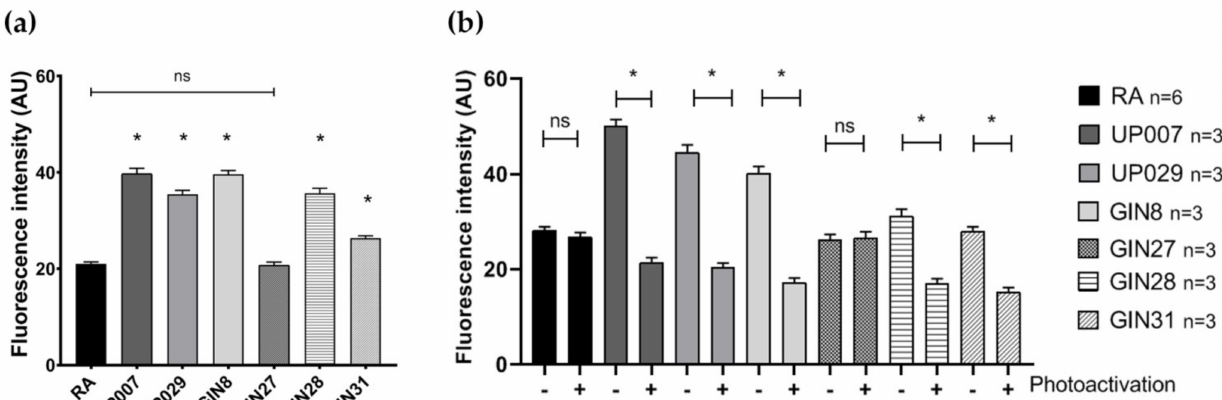
Figure 2. Mitochondrial membrane potential in RA and GBM cells, as reflected by TMRM florescence intensity. ( a ) Baseline MMP. GBM cells, except for GIN27, have greater basal MMP than normal RA. ( b ) Recovery of MMP 24 h after photoactivation. Normal RA and GIN27 GBM cells successfully recovered their normal MMP 24 h after photoactivation. Loss of MMP in other GBM cells persisted after 24 h. N: represents the number of independent experiments. 15+ cells were examined in each experiment. (*) p value < 0.0001, (ns) p value > 0.9999 (not